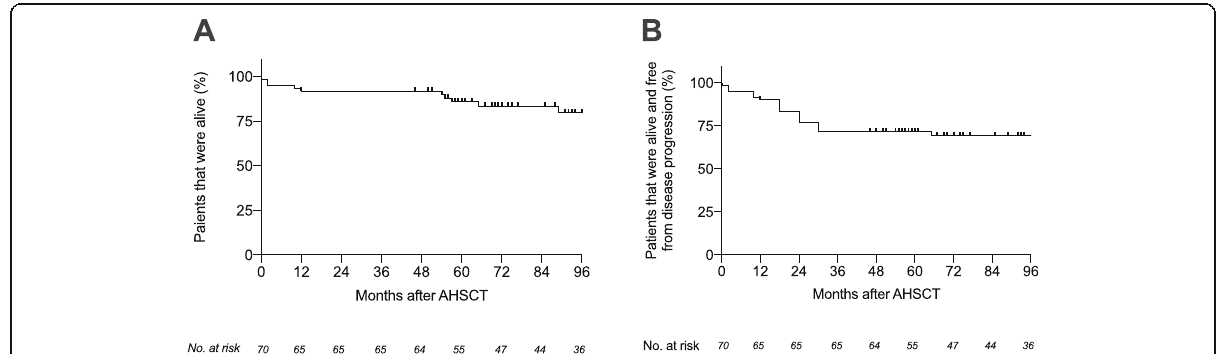
Fig. 3 Survival outcomes over 8-year follow-up after transplantation. a Overall survival; percentage of patients that were alive at each yearly follow-up time point. b Progression-free survival; percentage of patients that were alive and free from disease progression at each follow-up time point. Disease progression criteria are described in the Patients and Methods section. The numbers of patients at risk, at each time point, are